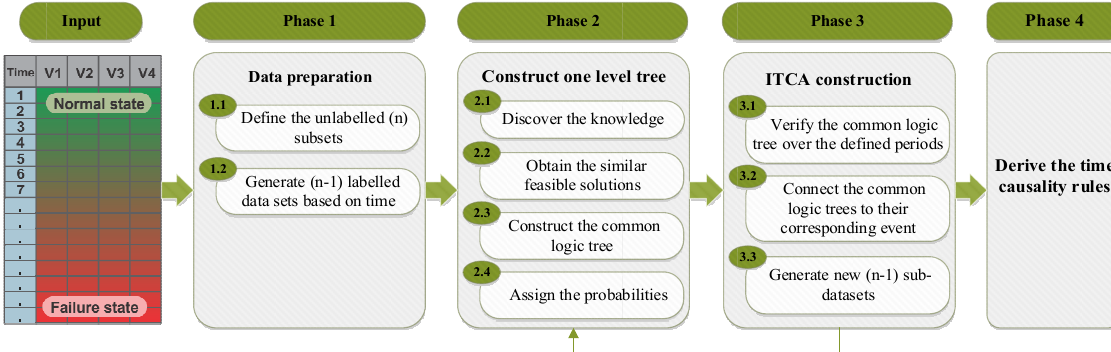
Figure 1. The four-phase ITCA